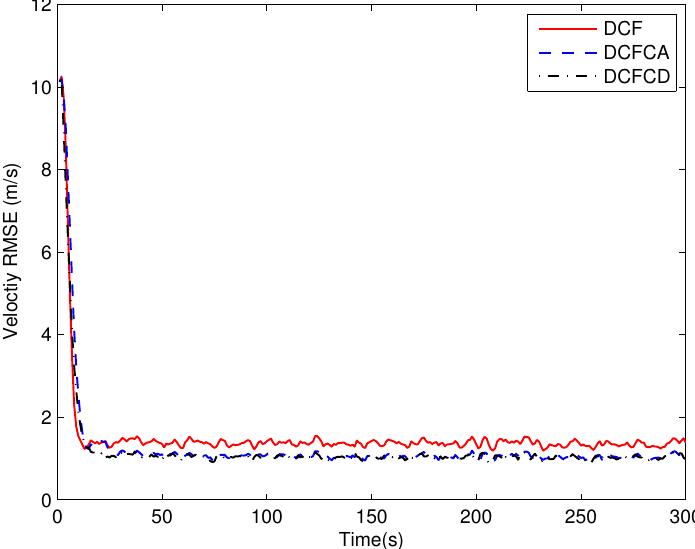
Figure 4. The velocity RMSE for different methods over time under colored